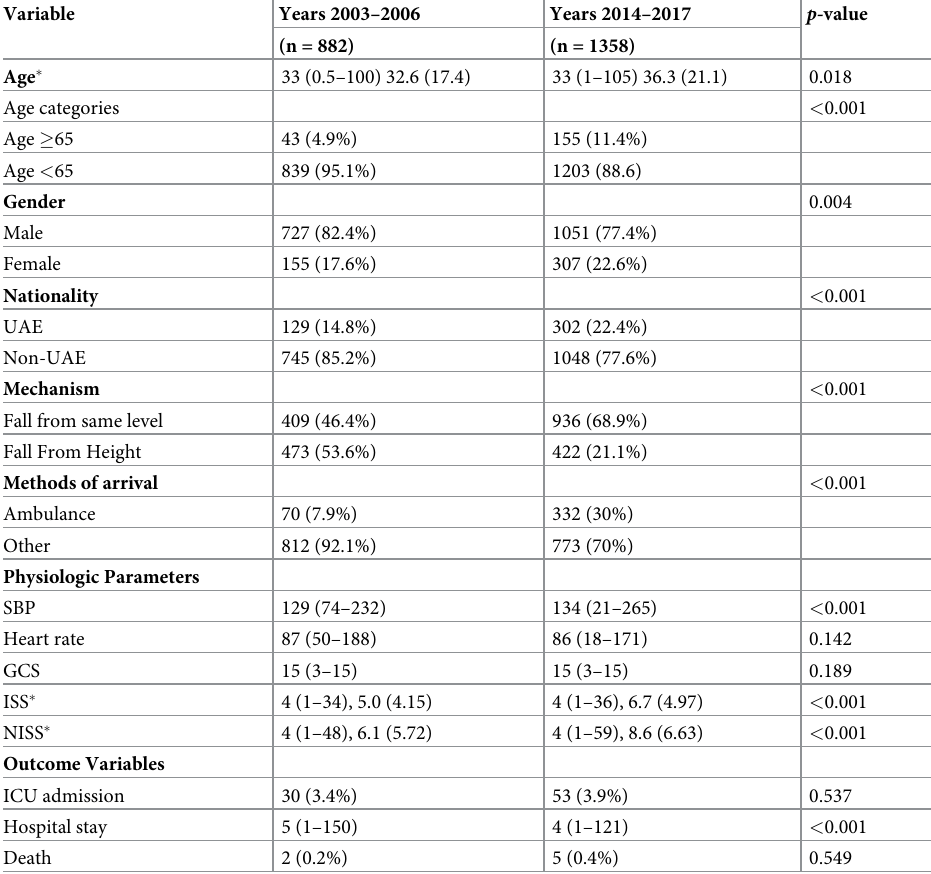
Table 1. Patients’ demographics, mechanism and parameters during the first period (2003–2006) and second period